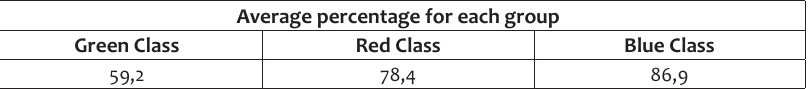
Table 1: Children’s interpretation of what is in their